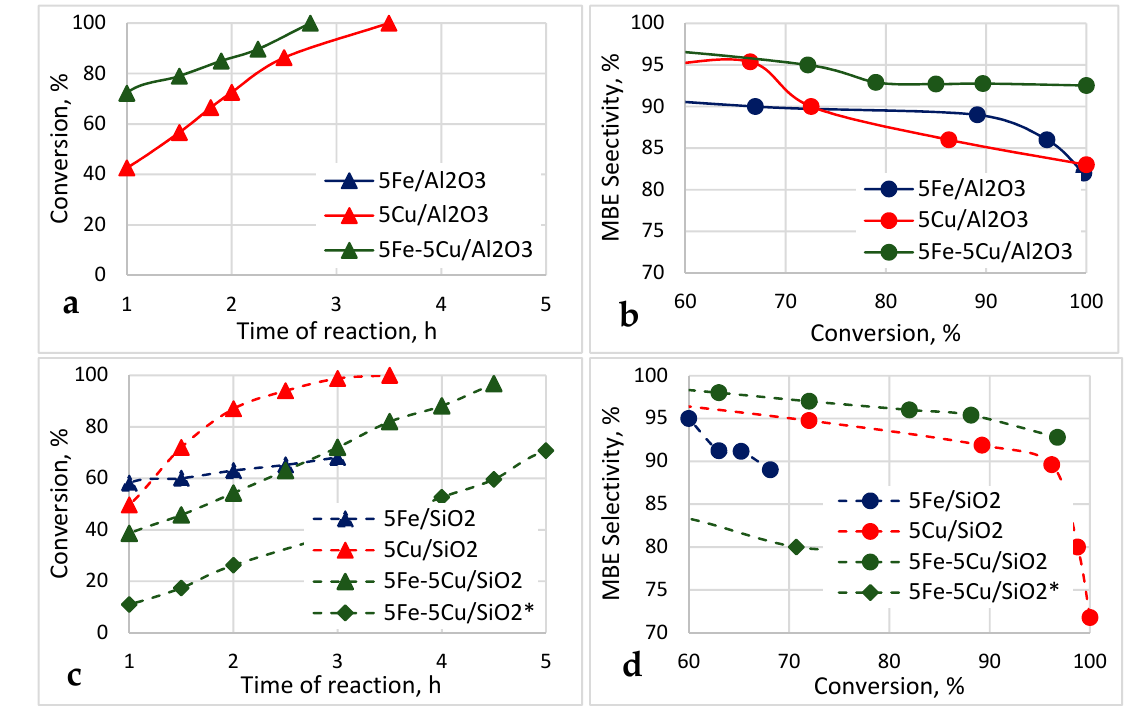
Figure 5. Time dependence of the MBY conversion ( a , c ) and the selectivity to MBE ( b , d ) for the 5Cu-5Fe samples supported on Al 2 O 3 and SiO 2 (*DPU method).